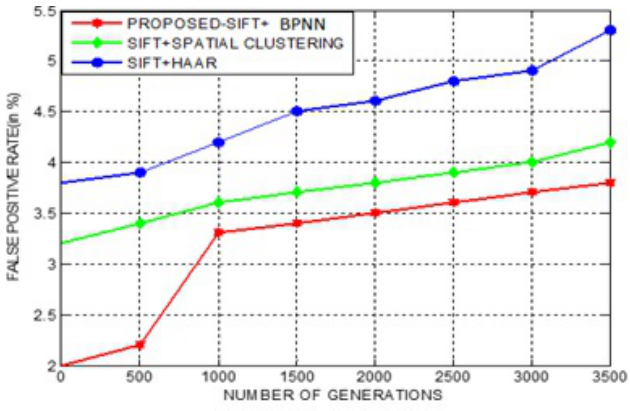
Figure 9. False positive rate of the proposed